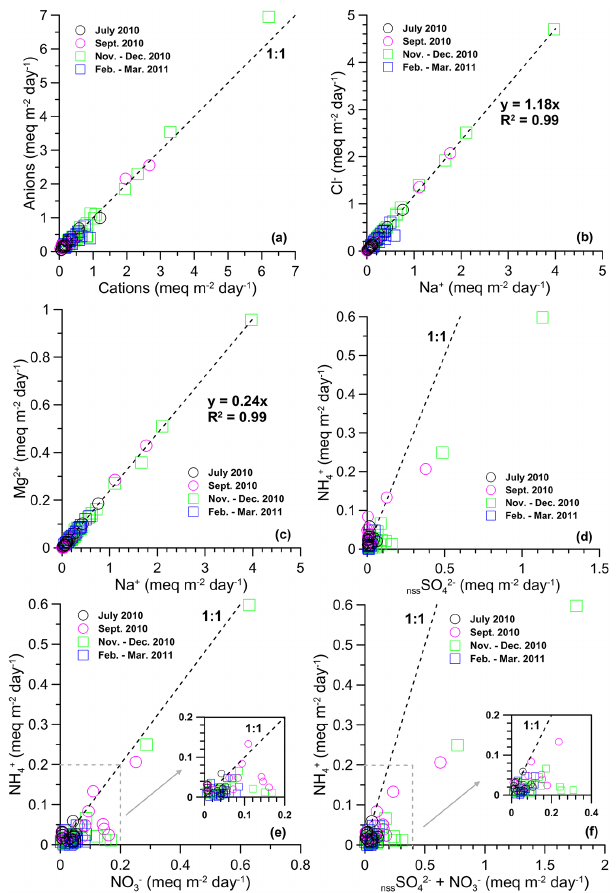
Fig. 2. Relationships for equivalent fluxes of (a) the total cations versus total anions, (b) Cl − versus Na + , (c) Mg 2 + versus Na + , (d) ) , (e) NH + NH + versus non-sea-salt SO 2 − ( nss SO 2 − versus NO − , 4 4 4 4 3 and (f) NH + vs. NO − plus nss SO 2 − in bulk atmospheric deposition 4 3 4 during collection